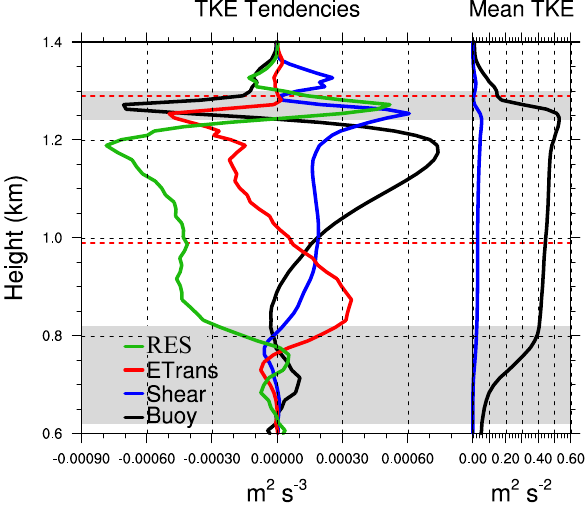
Fig. 10. Horizontally and temporally averaged profiles of turbulent kinetic energy (TKE) and TKE tendencies. (Left) Resolved TKE tendencies in units of m 2 s − 3 , with terms defined in text. Resid- ual=pressure transport plus dissipation. (Right) Mean resolved (black) and subgrid (blue) TKE, in units of m 2 s − 2 . Entrainment zones indicated with gray shading. Cloud layer top and base indi- cated by red dashed lines.